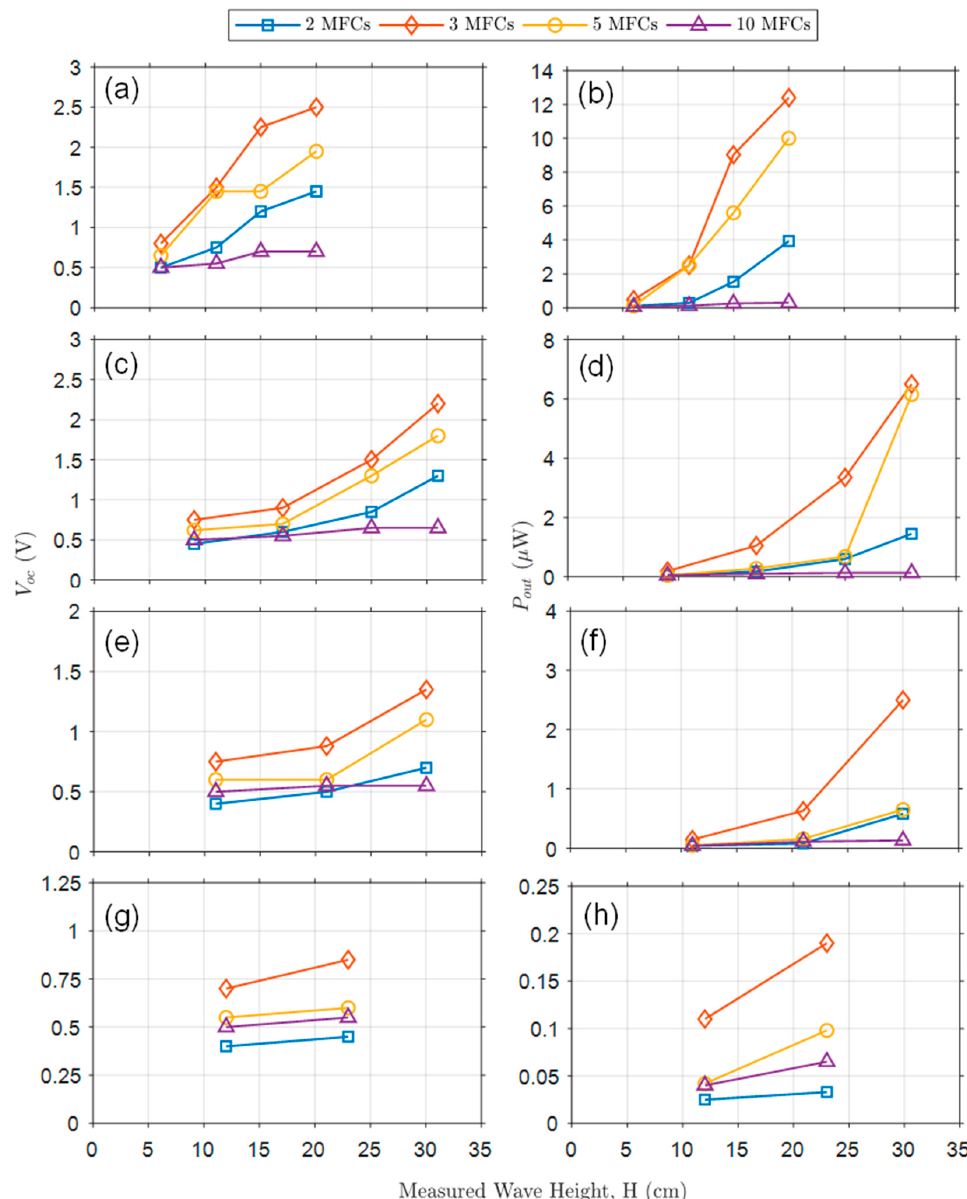
Figure 7. Graphs showing V OC and P OUT as a function wave height for a specific wave period and for OWECs with varying numbers of MFCs (2, 3, 5, and 10). ( a , b ) V OC and P OUT for 0.75 s wave period. ( c , d ) V OC and P OUT for 1.00 s wave period. ( e , f ) V OC and P OUT for 1.25 s wave period. ( g , h ) V OC and P OUT for 1.50 s wave period.